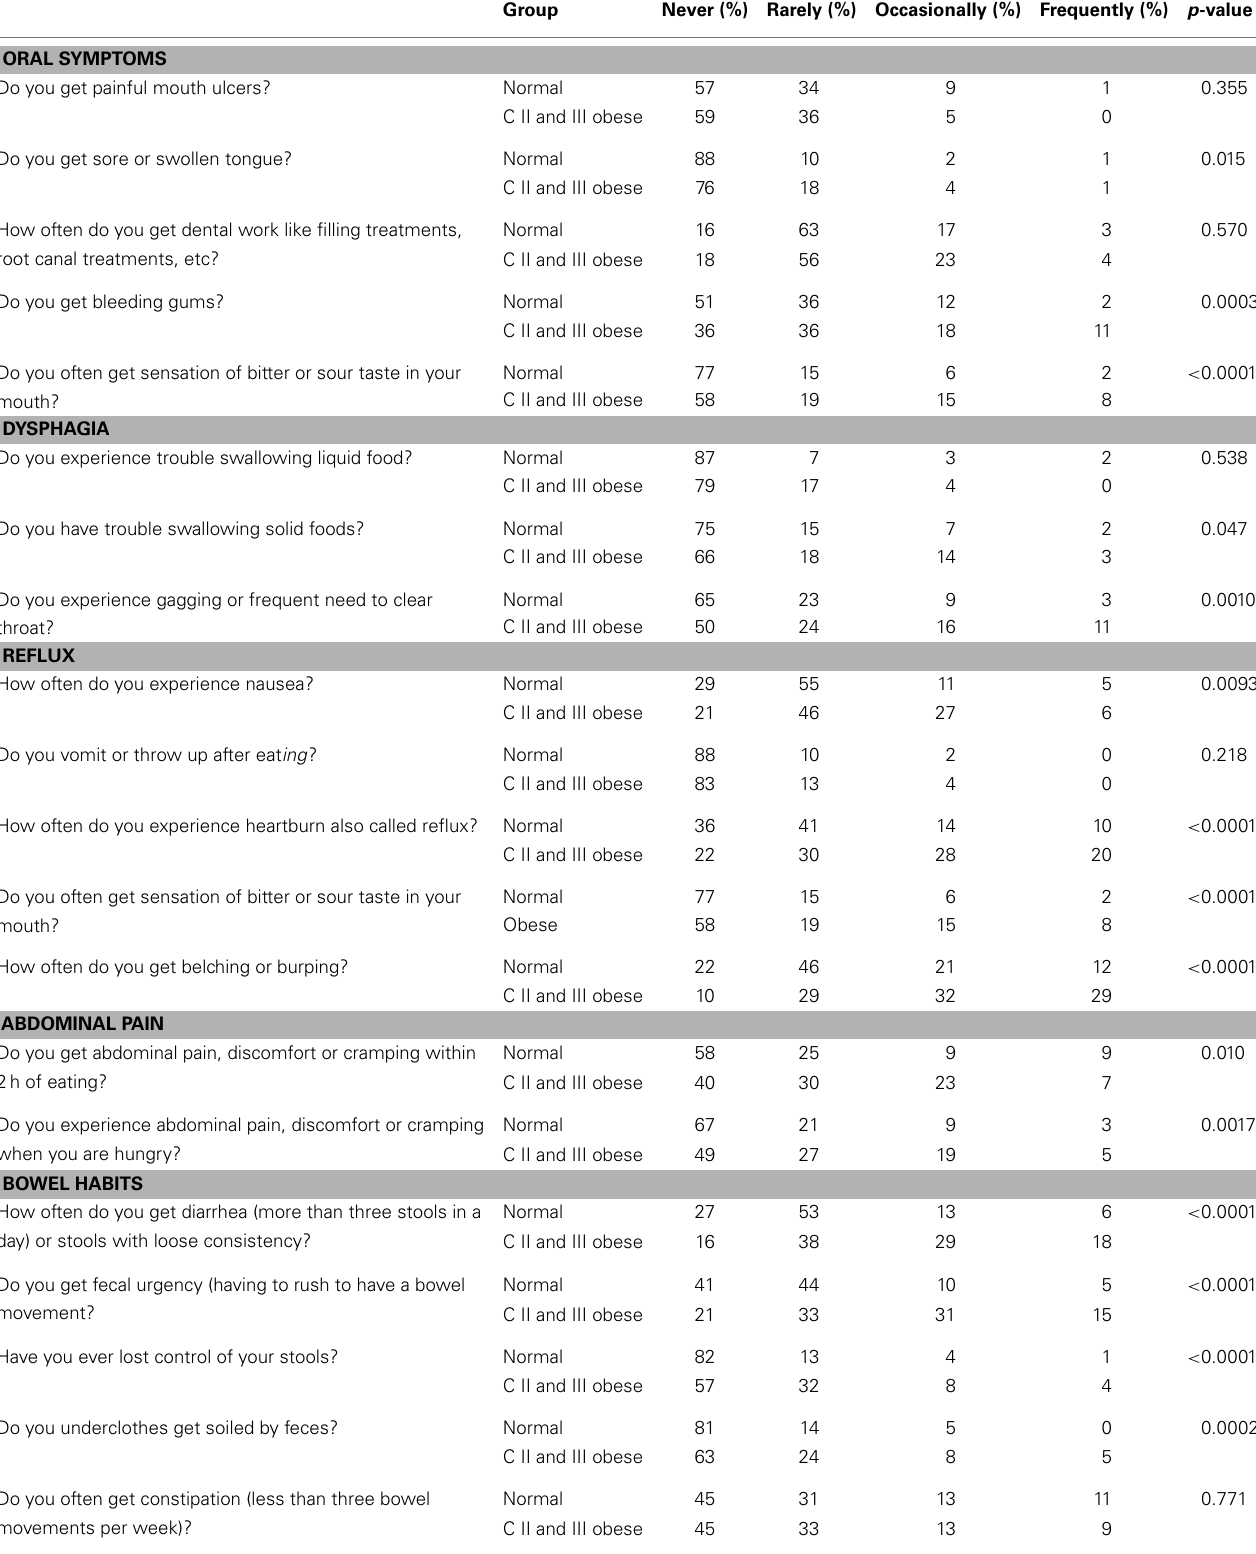
Table 1 | GI symptom survey responses by symptom category (114 obese patients and 182 normal weight patients)